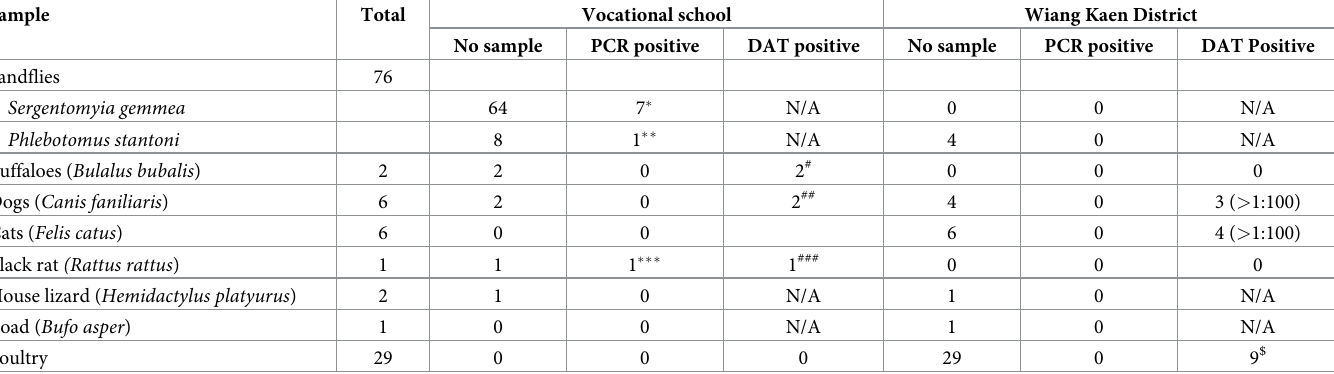
Table 2. Detection of Leishmania DNA among animals and trapped sandflies in the study areas of a vocational institute, an urban area and a mountainous rural area in Wiang Jaen District, Chiangrai Province, northern Thailand. Direct Agglutination Test (DAT) was used to detect antibodies in animal plasma.